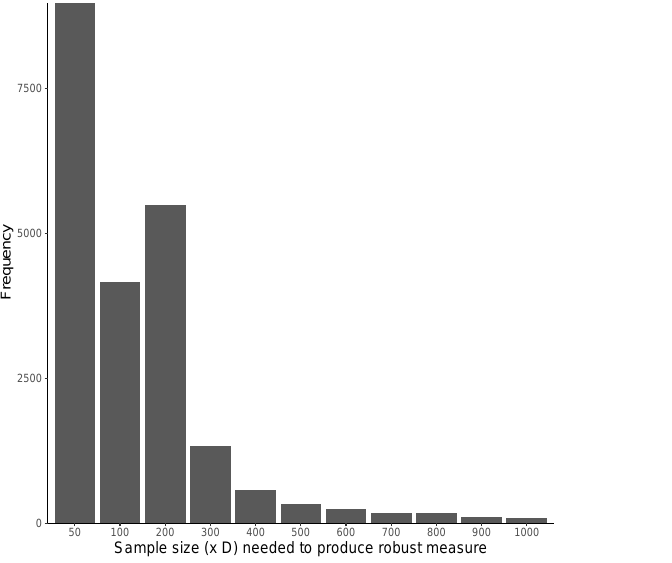
Figure 3. Plot of the combined distribution of the point of robustness of all investigate benchmark functions in D = 10